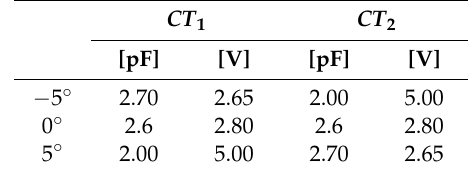
Table 10. CT combinations for different angular variations.